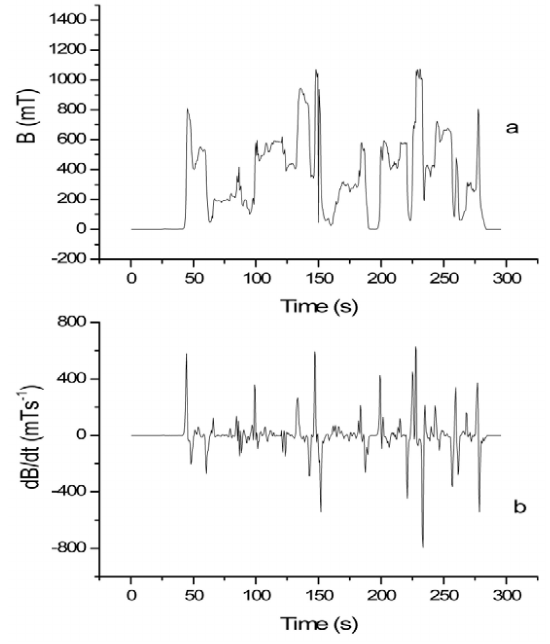
Figure 1. The measurement related to the TSMD_2 dosimeter, used on a 1.5 T site, and placed on the MRI technician’s torso. The data were recorded during patient positioning. ( a ) the exposure is shown; ( b ) the corresponding determined dB/dt curve is